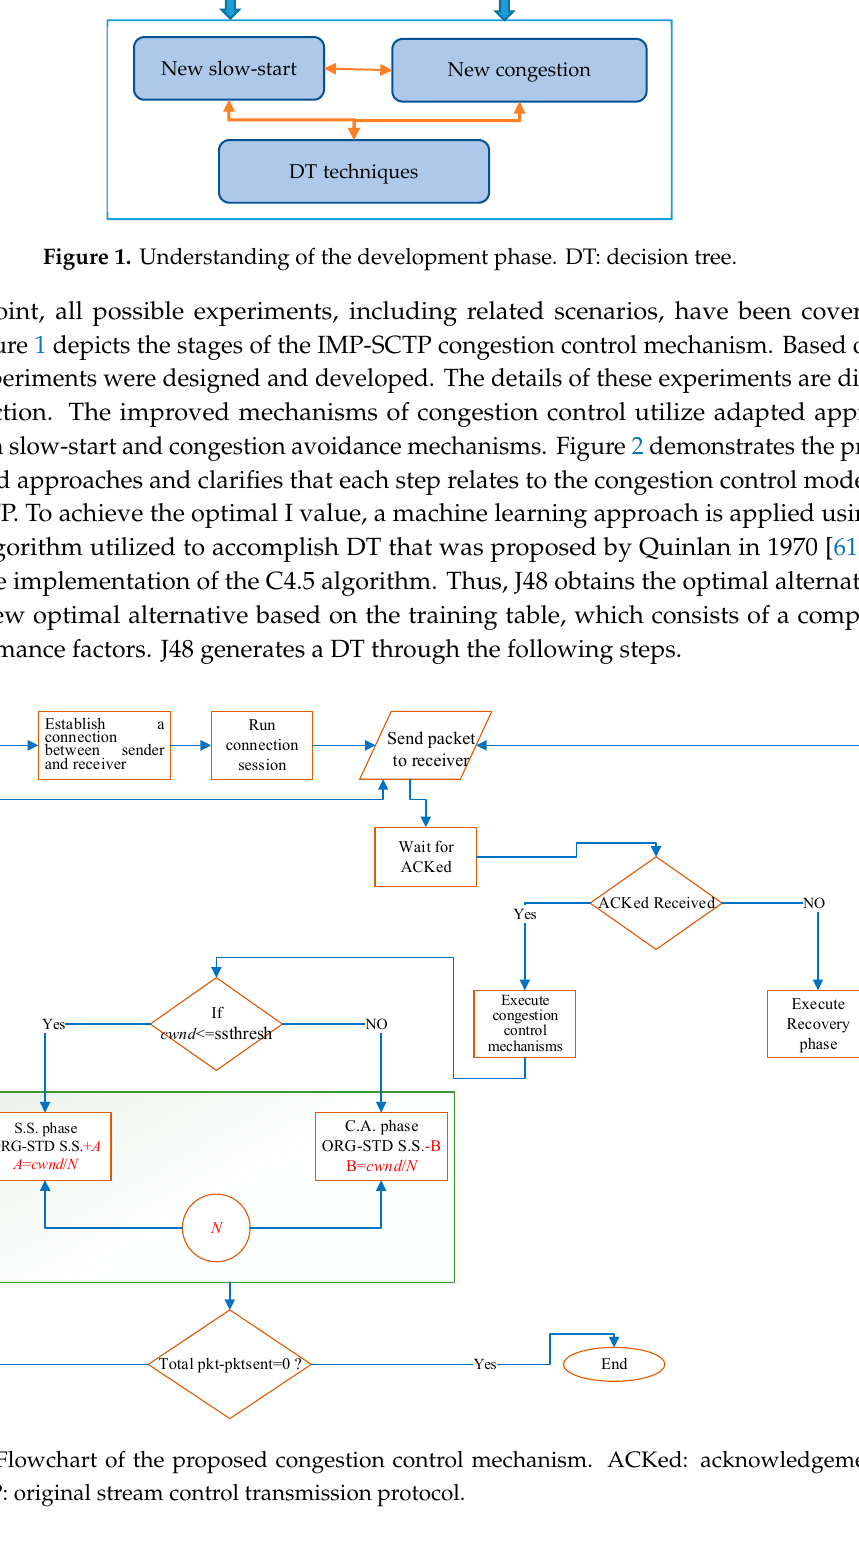
Figure 2. Flowchart of the proposed congestion control mechanism. ACKed: acknowledgement;